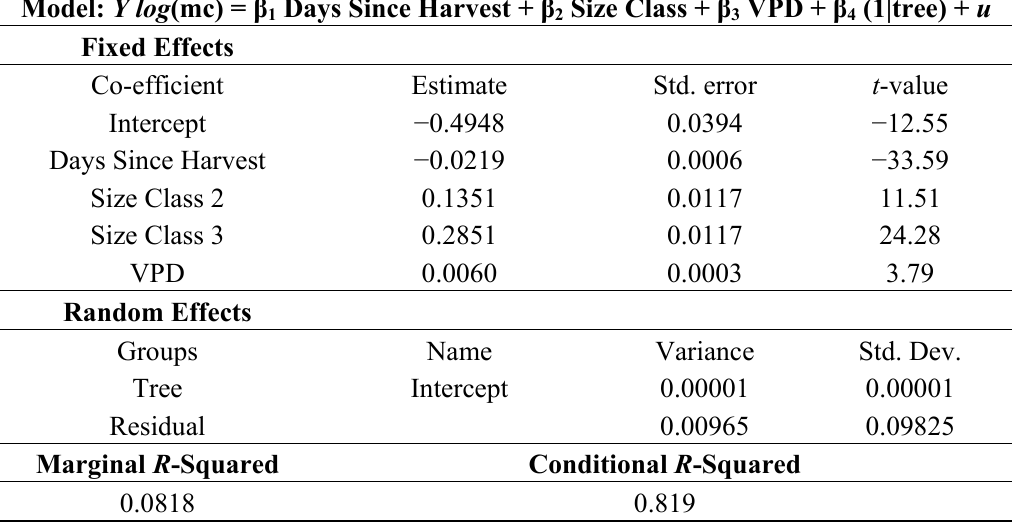
Table 6. The regression values of a generalized linear mixed effects model assessing moisture content of felled stems using Treatment 1 as the base